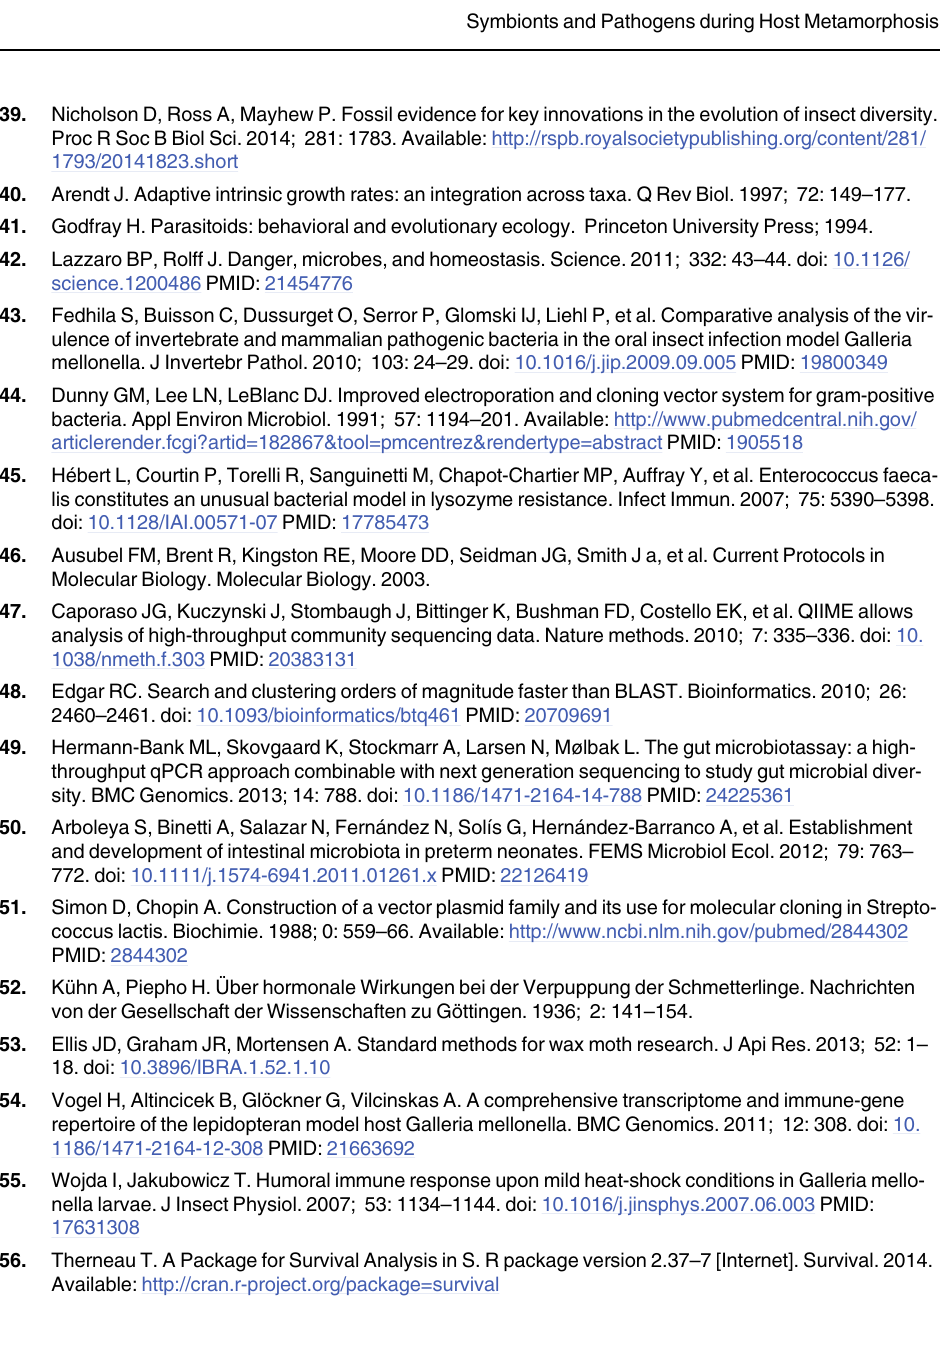
PLOS Pathogens | DOI:10.1371/journal.ppat.1005246 November 6,